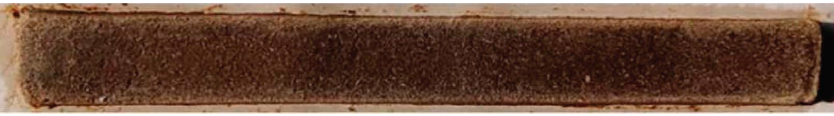
Figure 2: Flexural test specimen.